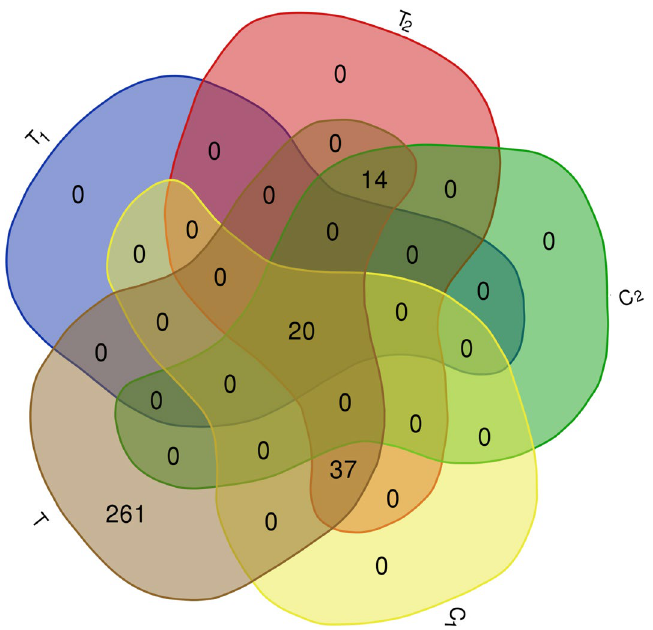
Figure 1. The Venn diagram of T 1 , T 2 , C 1 , C 2 and T sets. The complete description of sets is presented in Table 1.